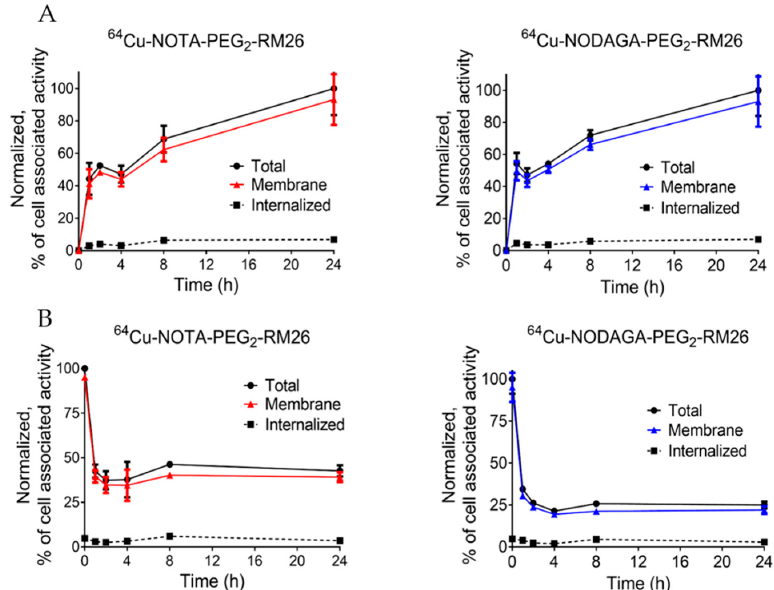
Figure 3. Binding and cellular processing of [ 64 Cu]Cu-X-RM26 (X = NOTA-PEG 2 , NODAGA-PEG 2 ) by GRPR-expressing PC-3 cells during ( A ) continuous incubation with 1 nM of [ 64 Cu]Cu-X-RM26 and ( B ) after interrupted incubation with 1 nM of [ 64 Cu]Cu-X-RM26. Cell-bound activity is normalized to the maximum uptake. Data are presented as mean value ± standard deviation. Error bars that are smaller than symbols may not be visible.